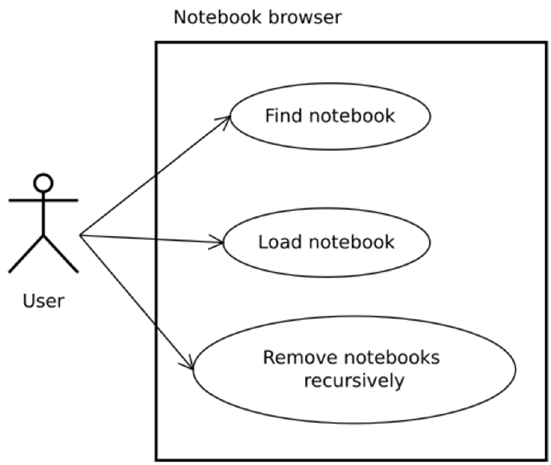
Figure 8. Notebook browser use case diagram.